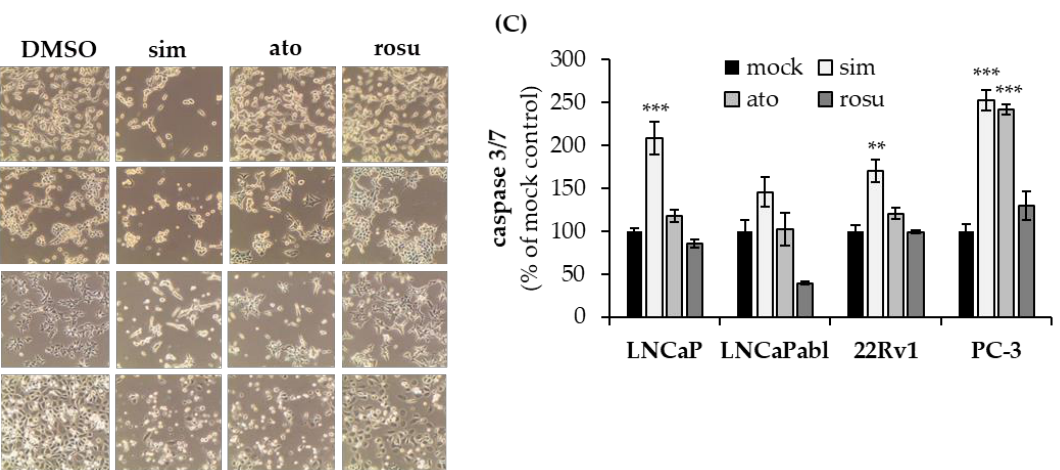
Figure 1. Growth-inhibitory effects of statins on different PCa cell lines. ( A ) Four different PCa cell lines (LNCaP, LNCaPabl, 22Rv1, PC-3) were treated with increasing concentrations of simvastatin (sim), atorvastatin (ato), and rosuvastatin (rosu) in the absence or presence of 5 µM enzalutamide (enza) over 72 h. Cell viability was assessed with a colorimetric CellTiter 96 ® Aqueous one solution cell proliferation assay and expressed as percentage of mock control (DMSO) that was set 100%. ( B ) Representative images were taken after 72 h of treatment with 5 µM of the indicated statin (100× magnification). ( C ) Induction of apoptosis was assessed after treatment of cells with 5 µM of each statin through a caspase 3/7 assay. Caspase 3/7 activity was expressed as percentage of mock control that was set 100%. Data are represented as mean ± SEM. (** p < 0.01, *** p < 0.001).